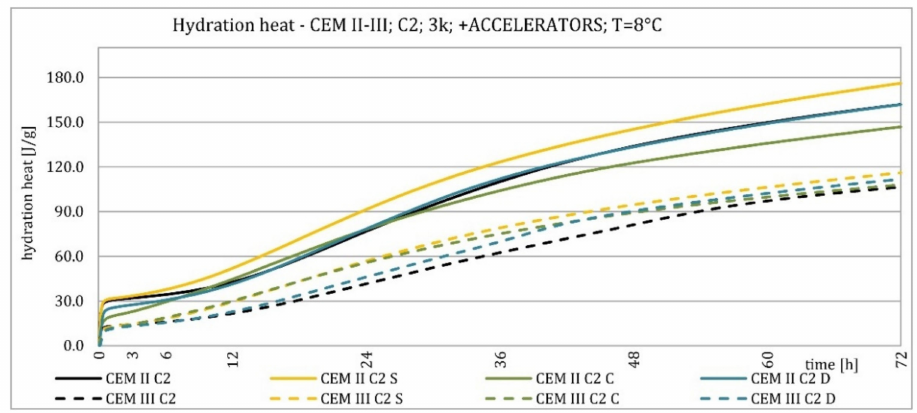
Figure 29. Hydration heat of C2 clinker-based cements CEM II/B-S, CEM III/A modified with accelerators at 8 ◦